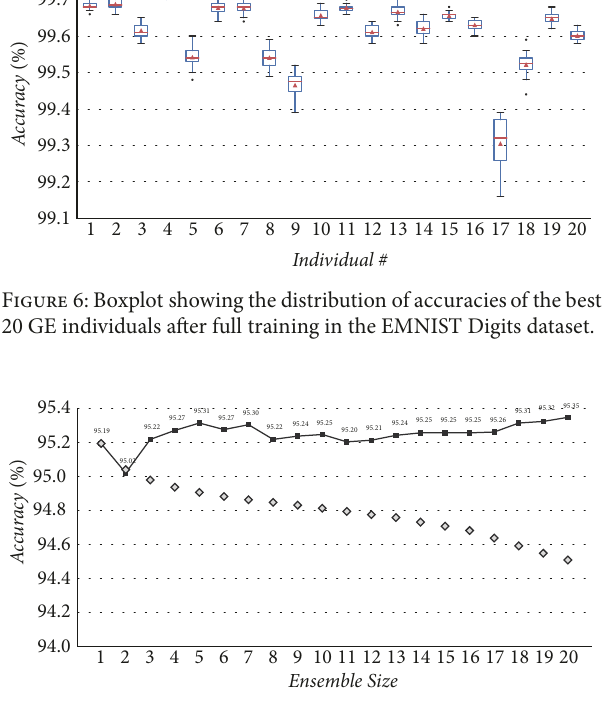
Figure 7: Accuracyof CNNscommittees with up to 20 models from GE with EMNIST